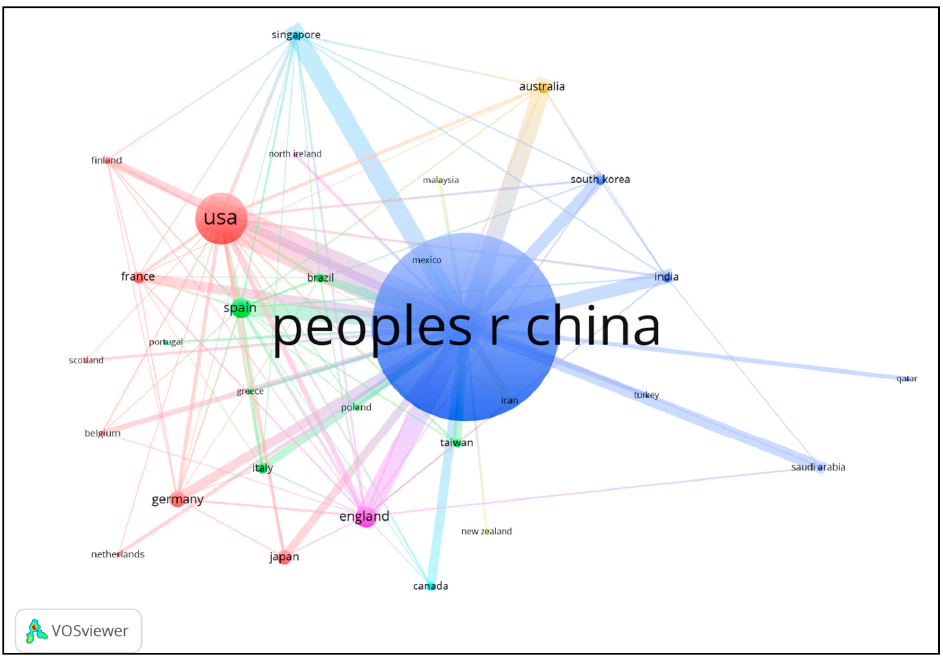
Figure 7. Bibliographic coupling of the authors in NC.